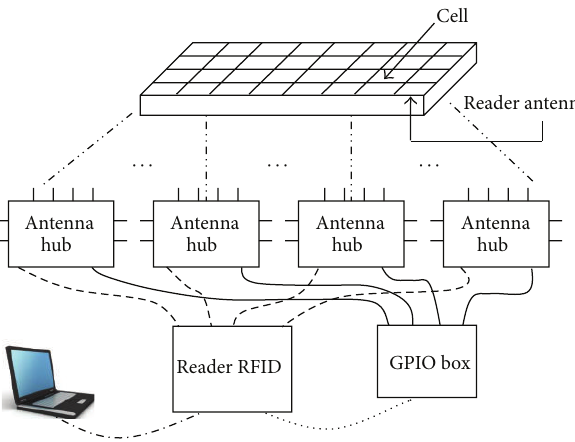
Figure 1: Hardware scheme of the proposed tracking